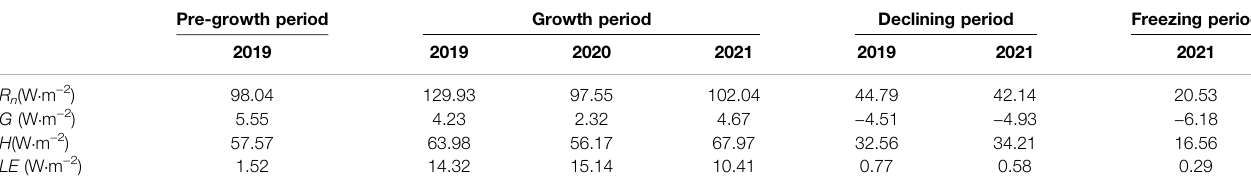
TABLE 3 | Daily mean values of energy components in different